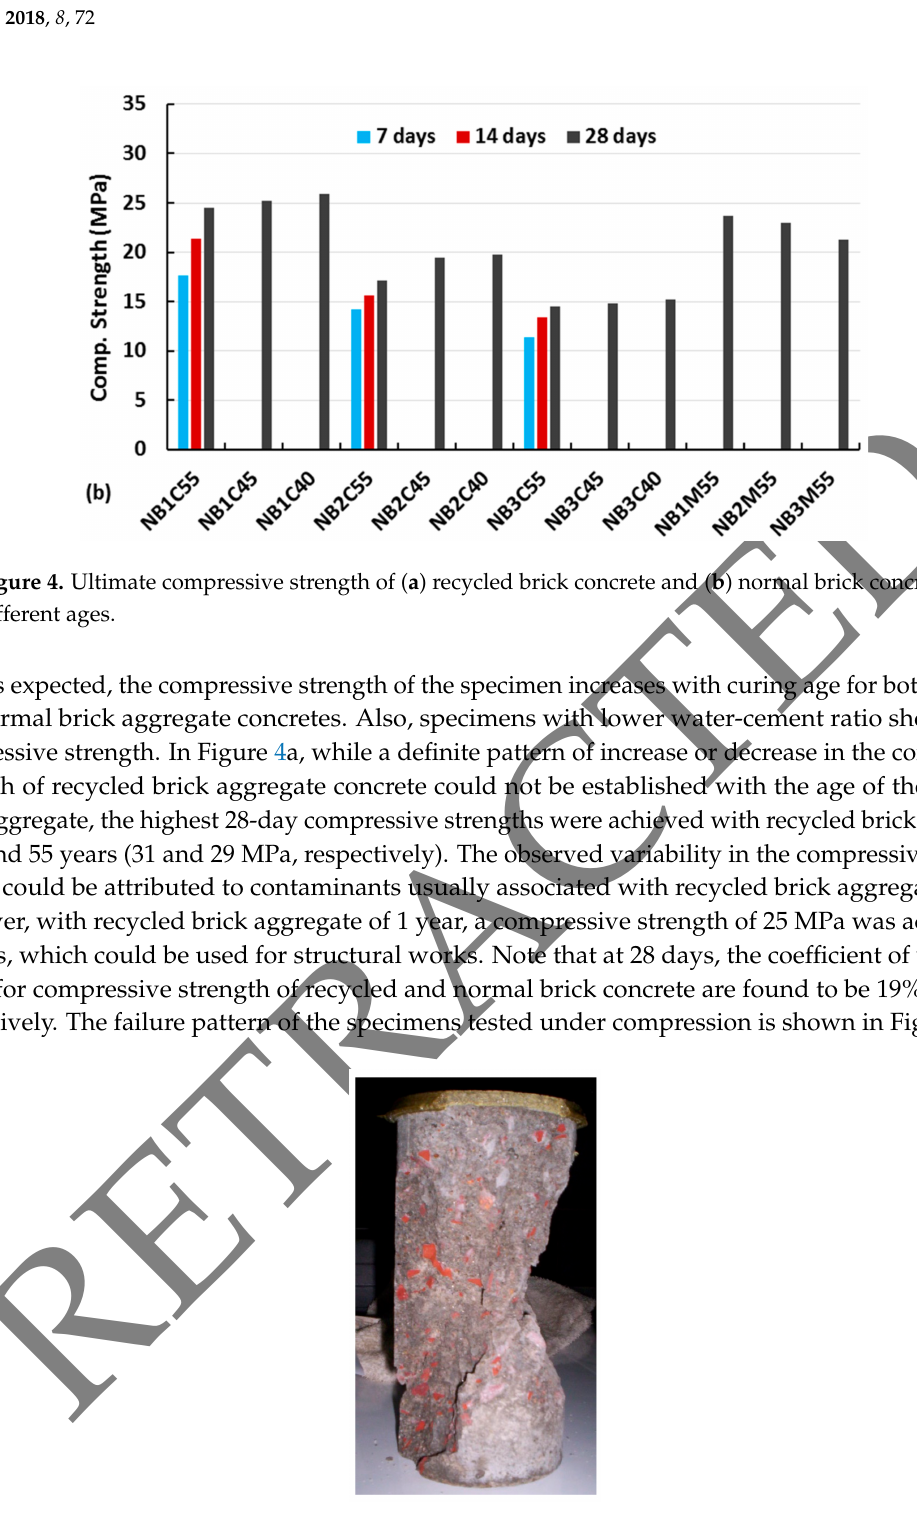
Figure 5. Failure surface of recycle brick